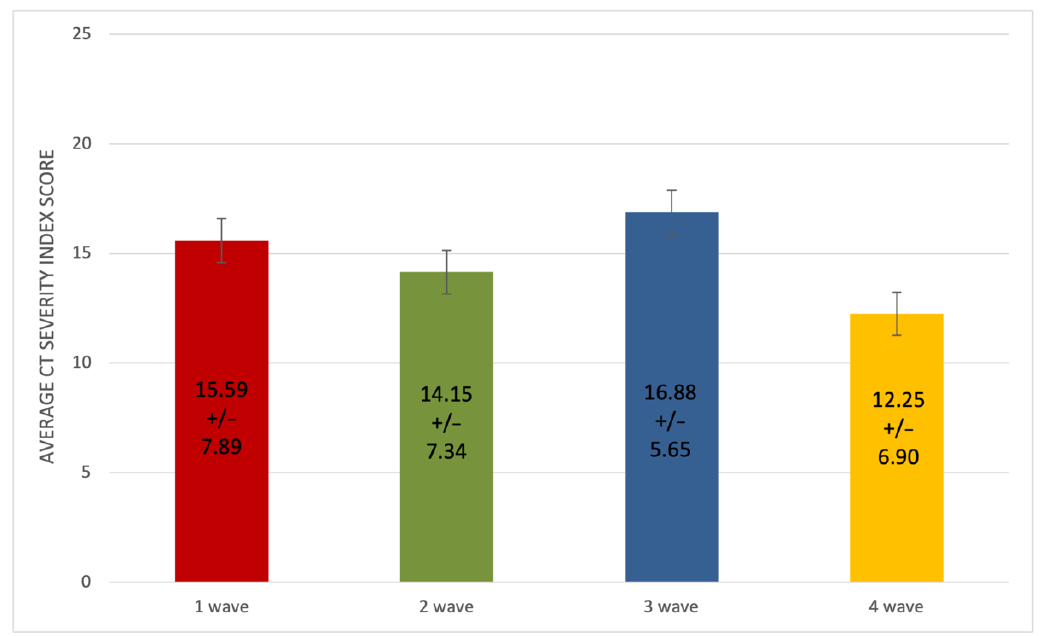
Figure 6. Comparison of CT scores (and ±SD) through the four waves of the disease.